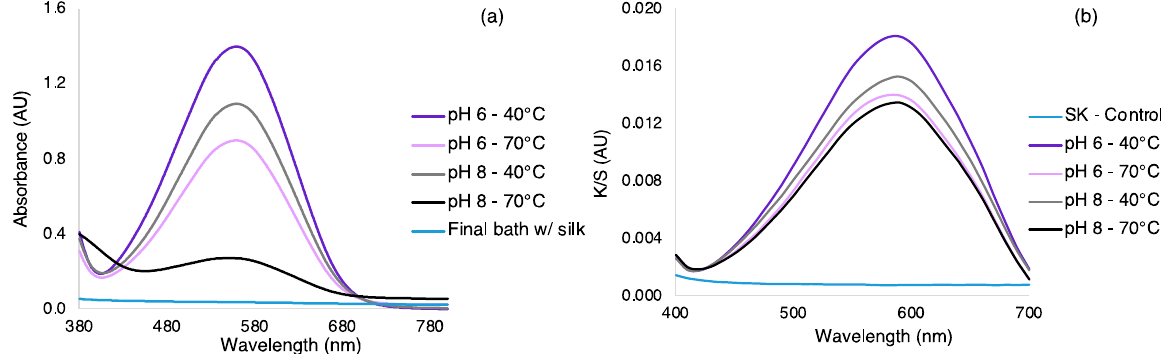
Figure 3. ( a ) UV-vis spectra of the control AzoIz.Pip solutions (1:2 diluted) (pH 6 and 8 and temperature at 40 and 70 °C) and UV-vis spectrum of the final bath of the exhaustion process with silk fabric, showing the complete adsorption of the dye; ( b ) K/S spectra of silk fabrics dyed with AzoIz.Pip dye using di ff erent exhaustion conditions.